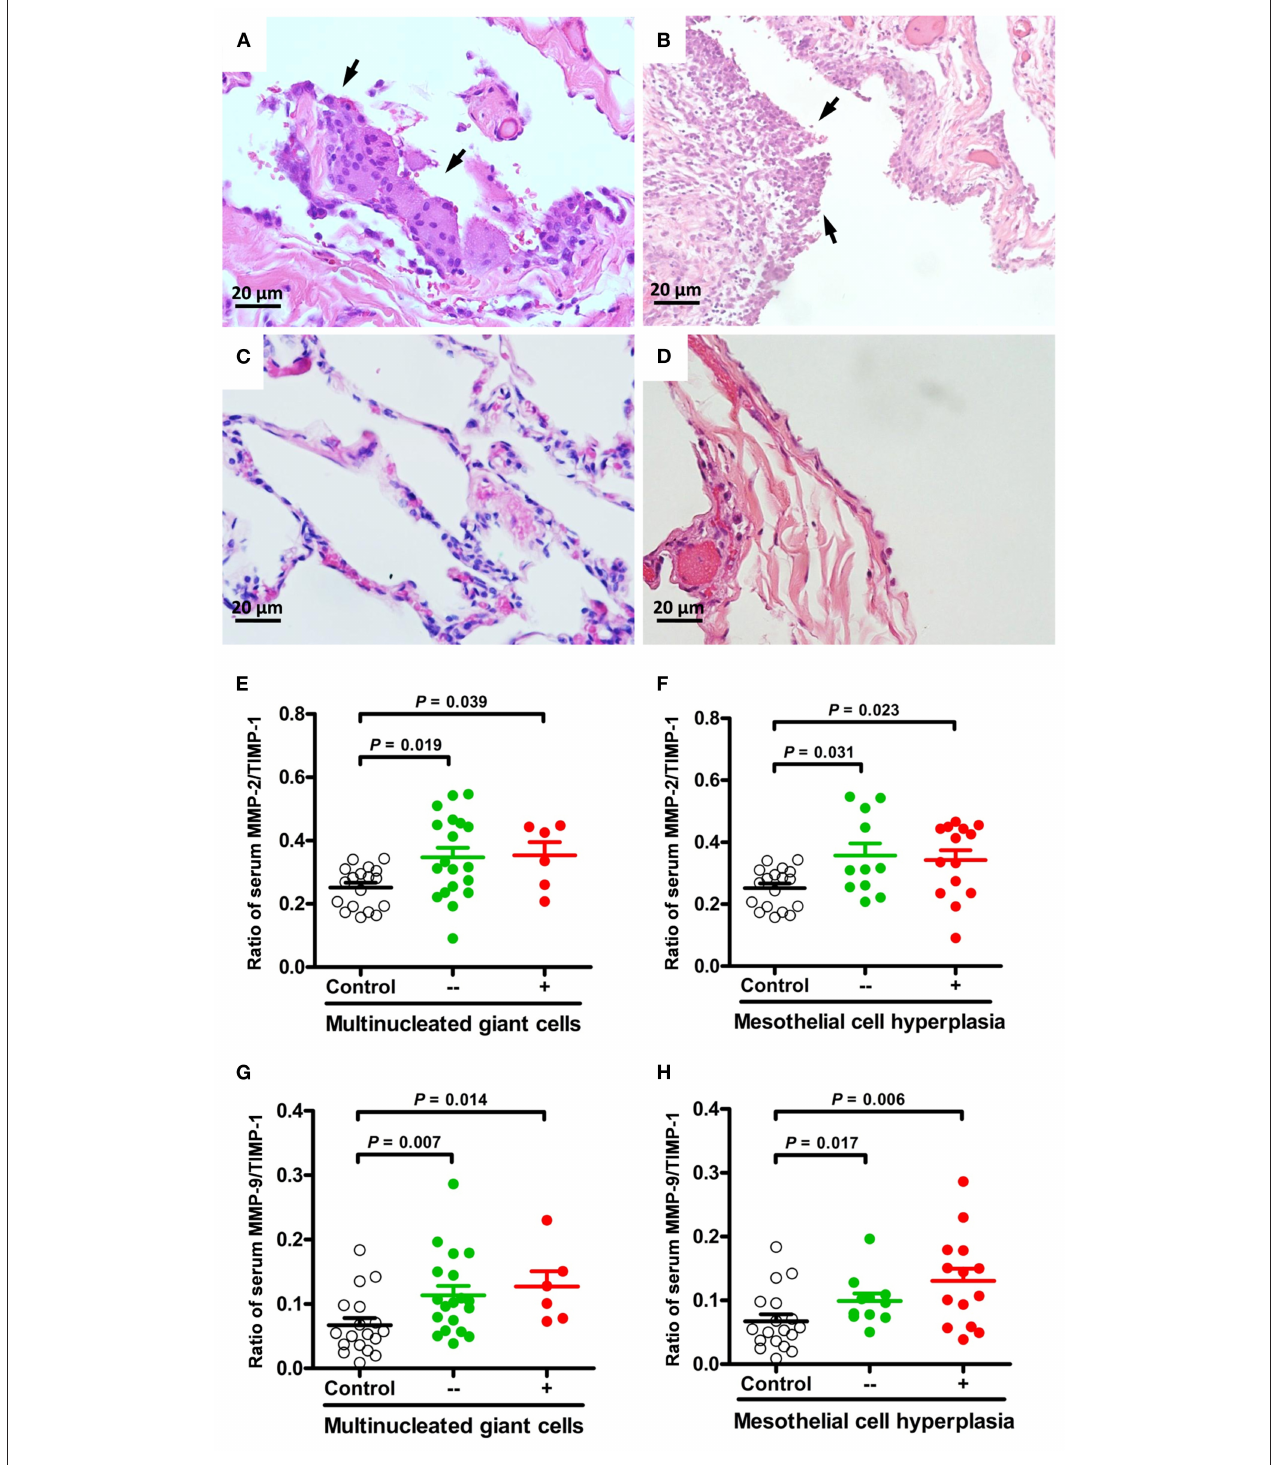
FIGURE 2 | Representative micrographs (H&E, × 400) of multinucleated giant cells and mesothelial cell hyperplasia in lung specimens of PSP patients. Foci of multinucleated giant cells lining the alveolar spaces [ (A) , arrows] compared to normal appearance (C) . Hyperplasia of the mesothelial cells lining the pleura [ (B) , arrows] compared to normal appearance (D) . Comparisons and differences of serum MMP-2/TIMP-1 and MMP-9/TIMP-1 ratios between PSP patients with and without multinucleated giant cells (E,G) , mesothelial cell hyperplasia (F,H) and healthy controls.